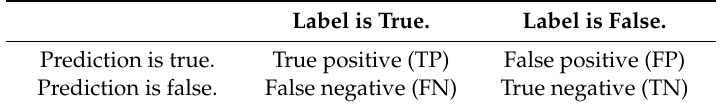
Table 1. Definitions of TP, FP, TN and